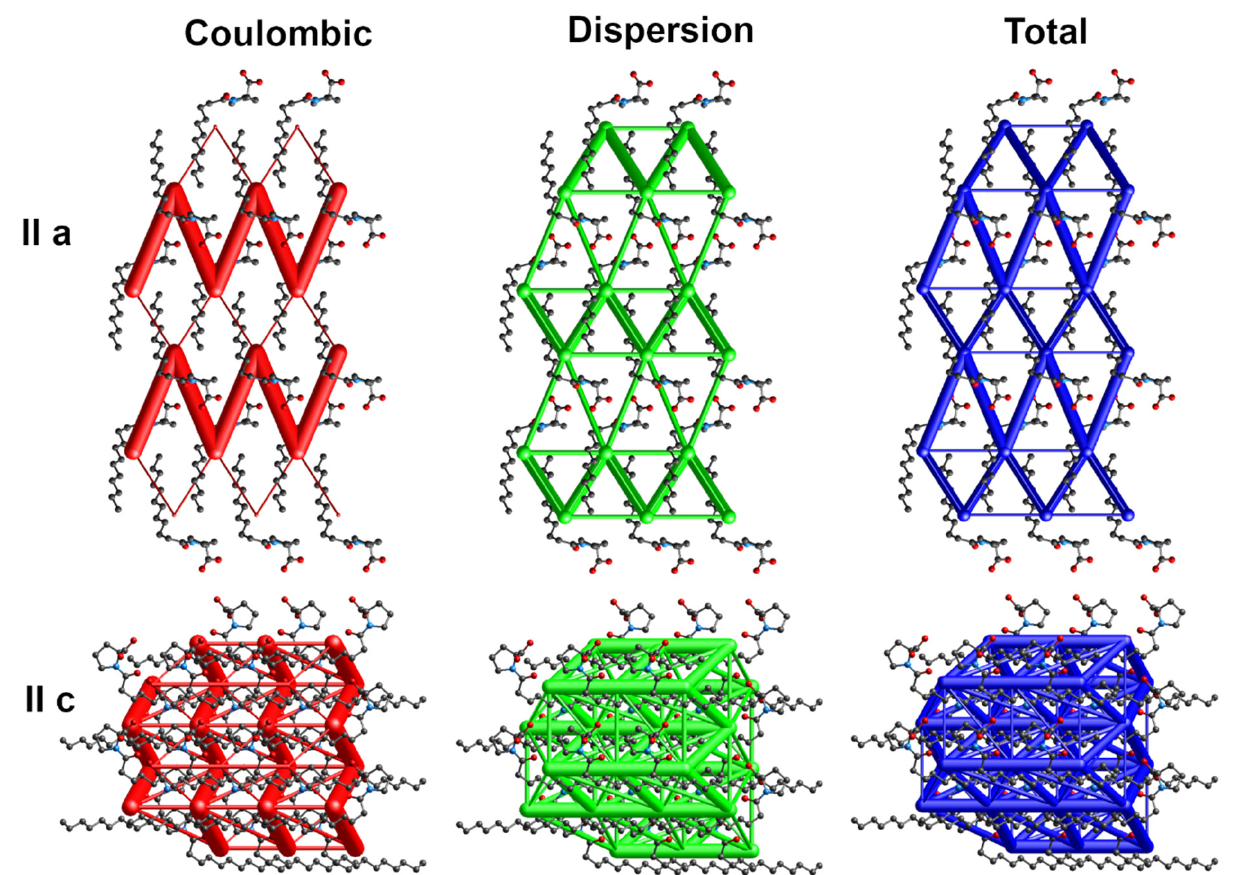
Figure 5. Energy frameworks for 2-Pro. View along a and c directions. Various colors represent various energy terms: red—coulombic, yellow—polarization, green—dispersion, and blue—total energy. The applied scale for tube size 150, the energy cut-off 5 kJ/mol.